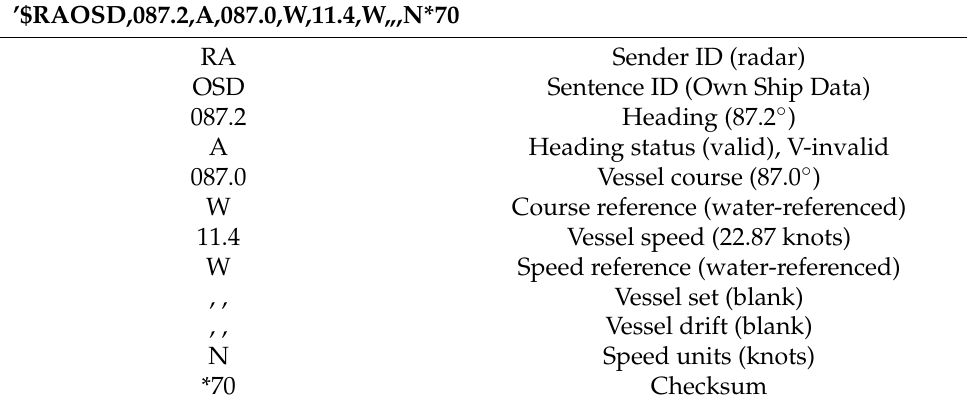
Table 2. An example of an Own Ship Data message-OSD transmitted by a